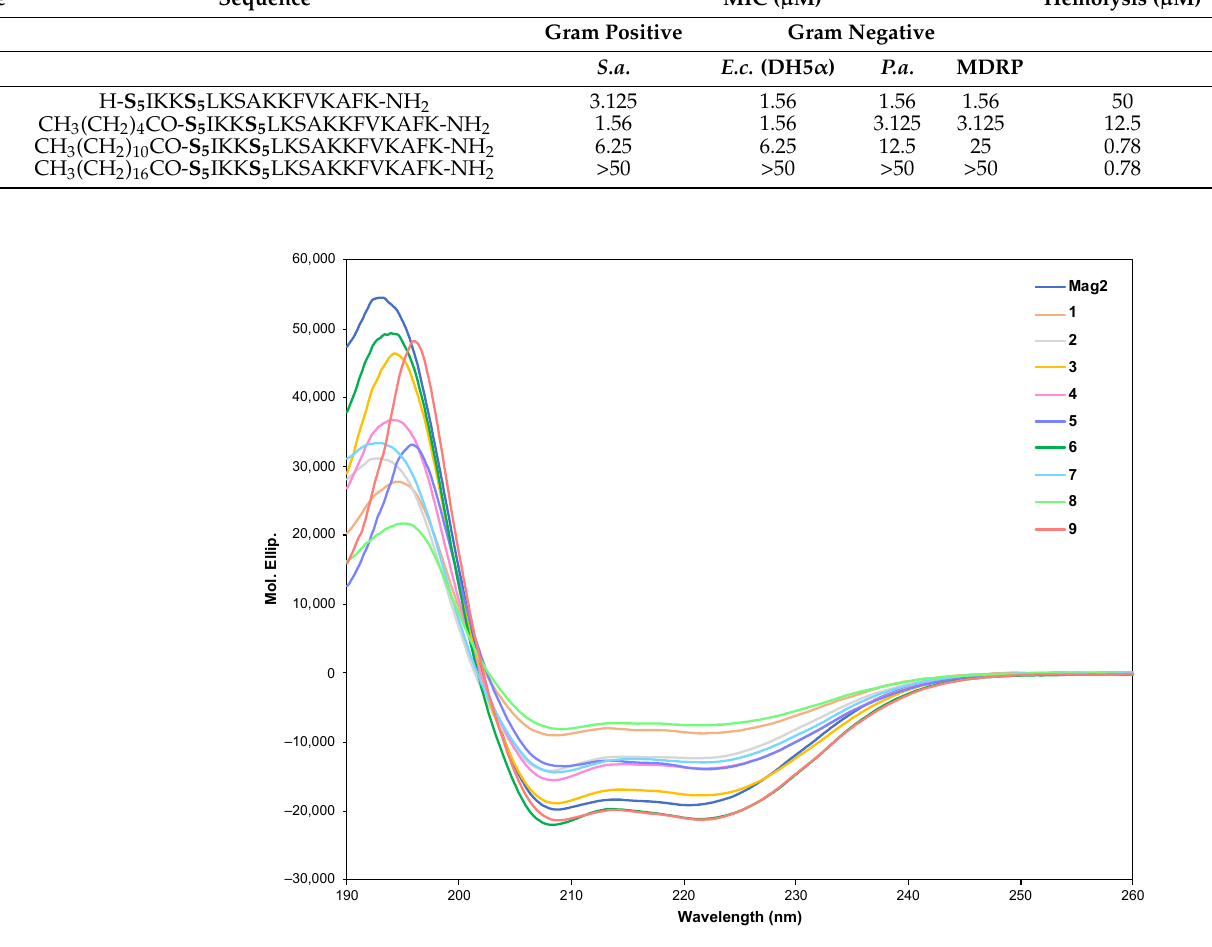
Figure 2. Preferred secondary structural analysis of Mag2 and peptides 1–9 in pH = 7.4 phosphate buffered saline solution with 1% sodium dodecyl sulphate. The mean residue ellipticity was plotted against wavelength. The values from three scans were averaged per sample. Peptide concentration = 100 µ M.